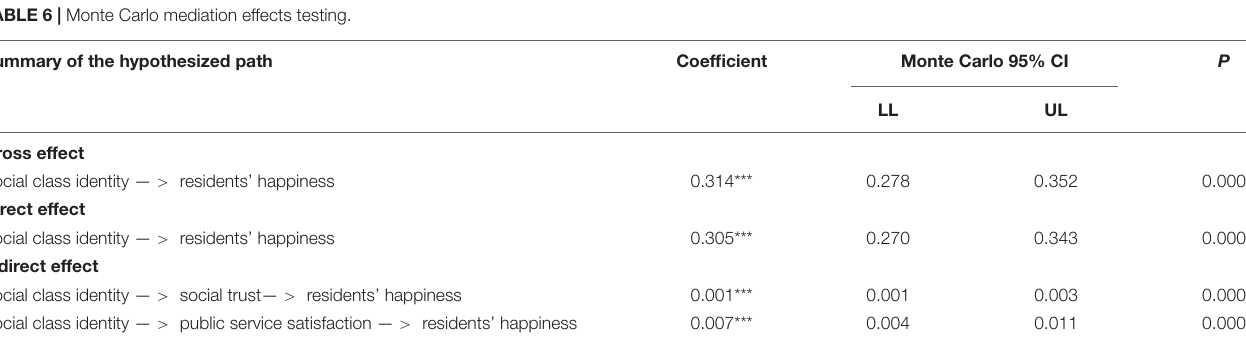
TABLE 6 | Monte Carlo mediation effects